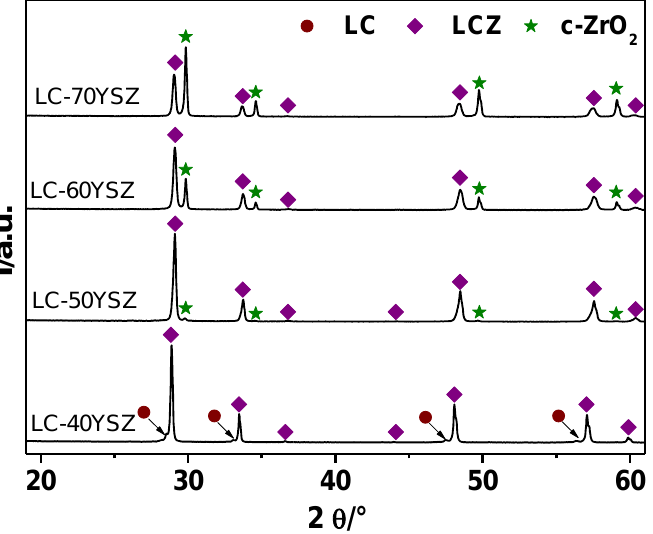
Figure 2. XRD patterns of the LC-YSZ bulk samples after hot pressing at 1400 °C.